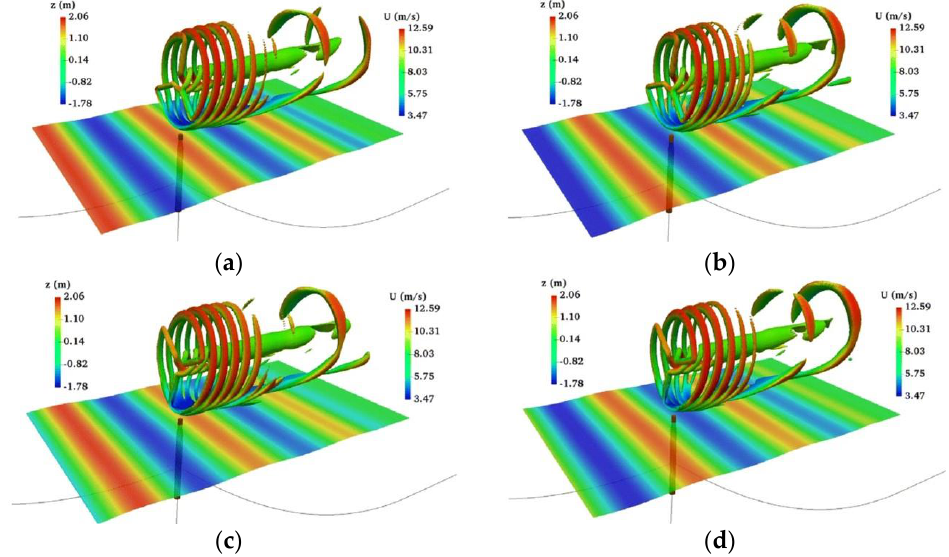
Figure 16. Instantaneous vortex structures of the spar buoy FOWT modeled by the unsteady AL: ( a ) t = 0; ( b ) t = 1/4 T wave ; ( c ) t = 2/4 T wave ; ( d ) t = 3/4 T wave [146]. Reproduced with permission from Huang et al., Journal of Marine Science and Application; published by Springer Nature, 2019.